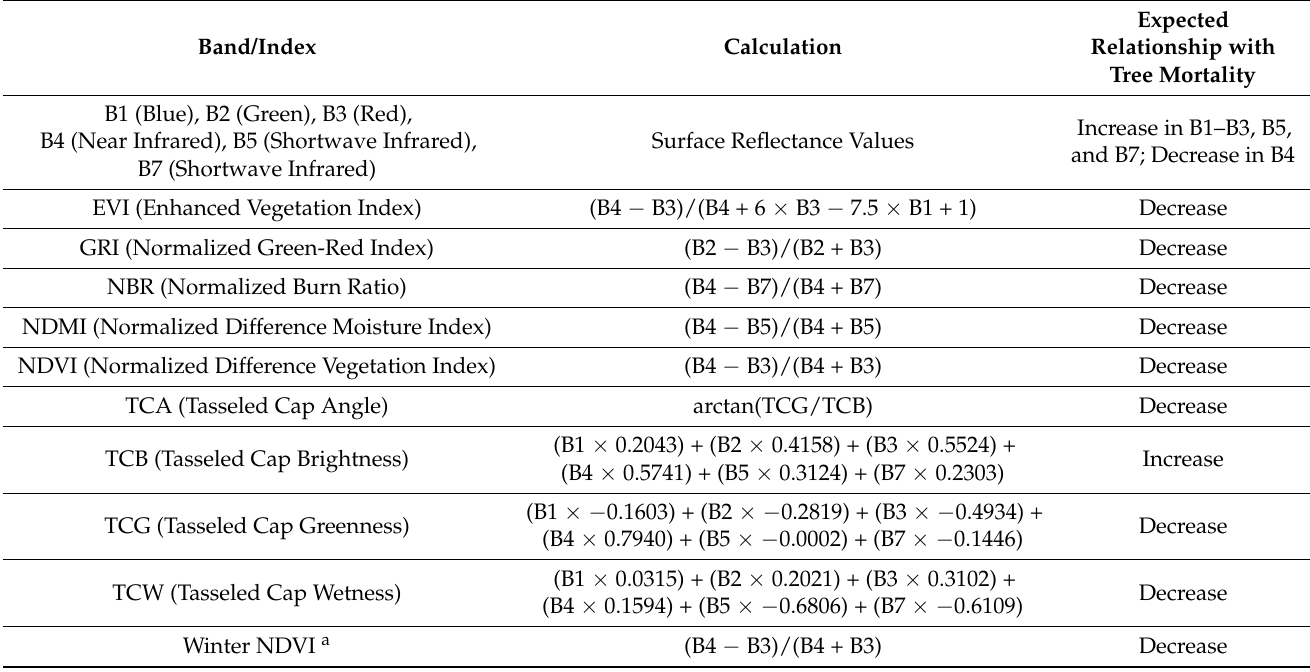
Table 1. Description of individual spectral bands and indices used in developing Landsat time series. Note that all formulas and band numbers refer to Landsat TM (Thematic Mapper) equivalents. Band/Index Calculation